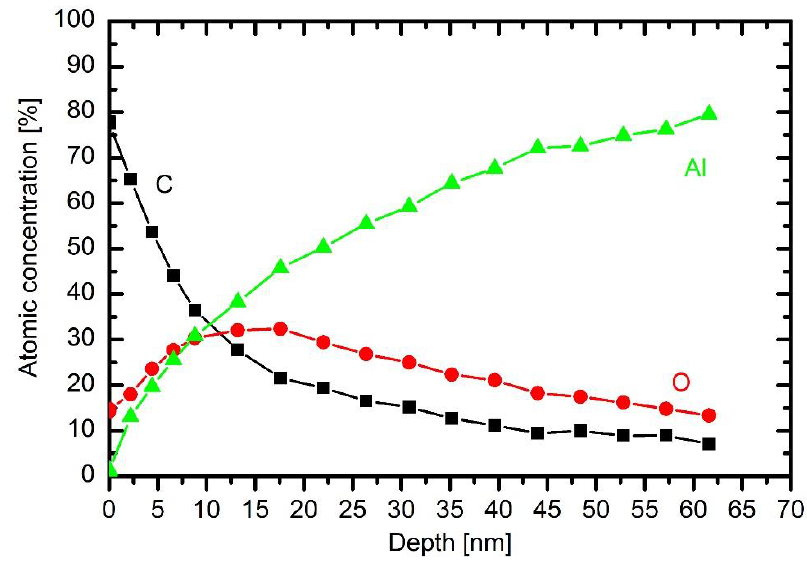
Figure 7. XPS depth profile of an untreated sample.